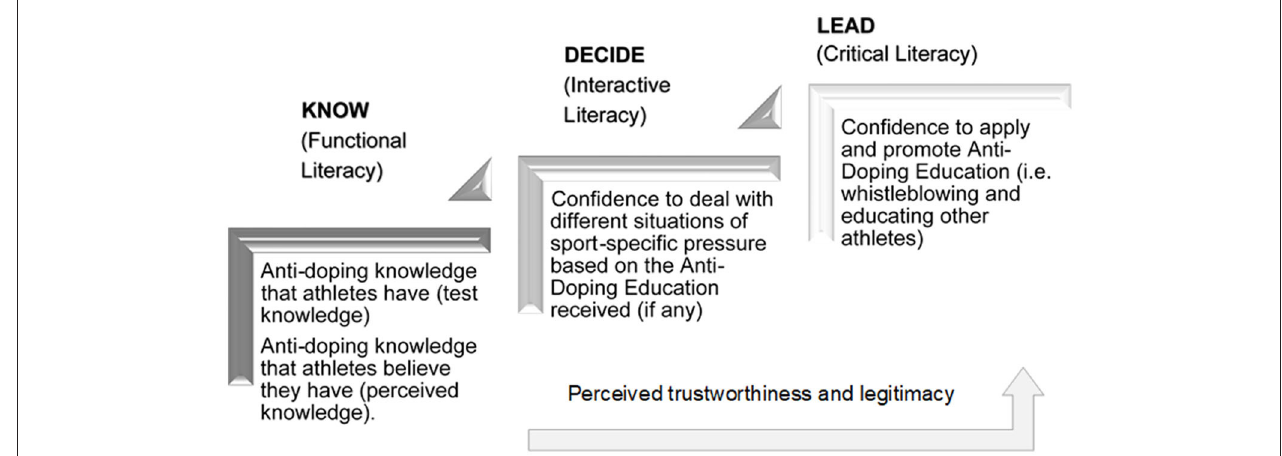
FIGURE 2 | Stages of DAL and associated